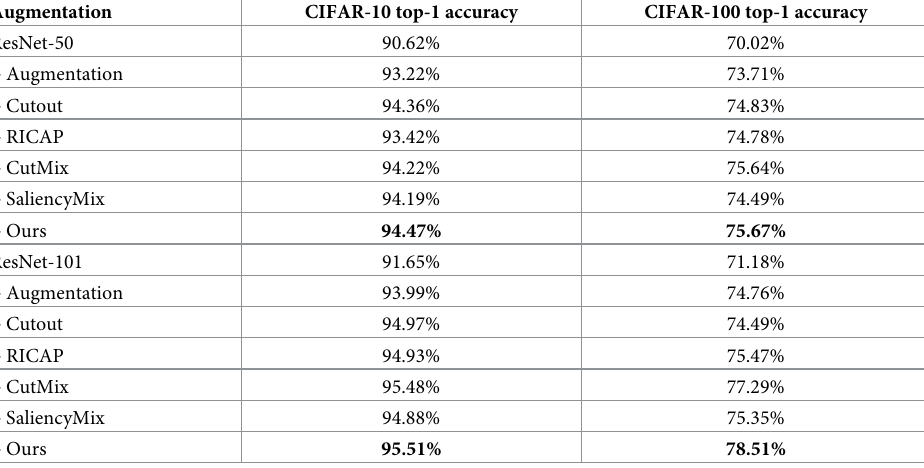
Table 3. Comparison of the classification performance by the ResNet-50 and ResNet-101 architectures on the CIFAR-10 and CIFAR-100 datasets.